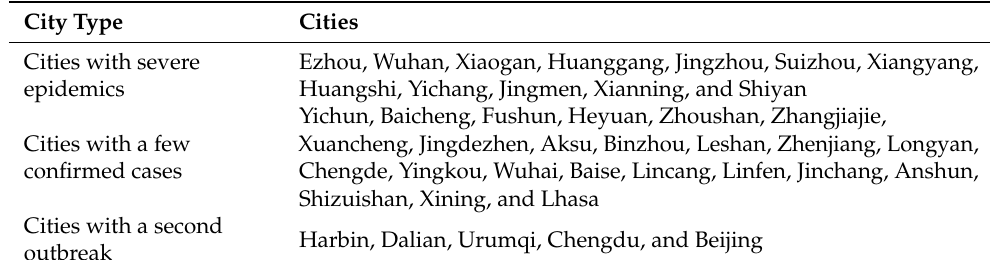
Table 1. Three types of cities studied in this